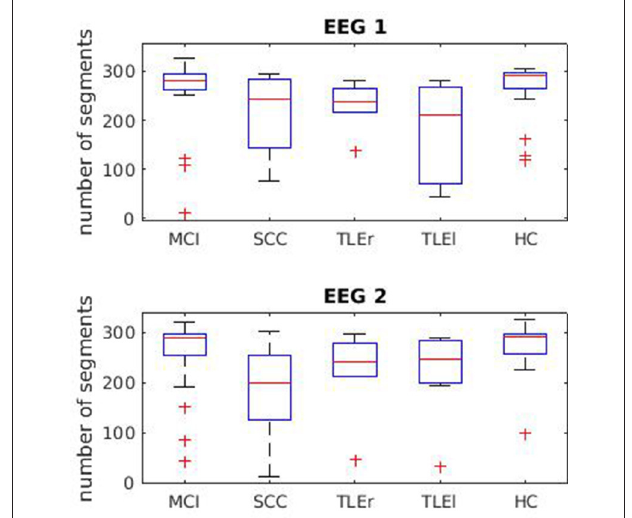
FIGURE 1 | Boxplots for segment numbers. Segment (trial) numbers for the first and second EEG recording. One segment equals half a second. MCI, mild cognitive impairment; SCC, subjective cognitive complaints; TLEr, right lateralized temporal lobe epilepsy; TLEl, left lateralized temporal lobe epilepsy; HC, healthy